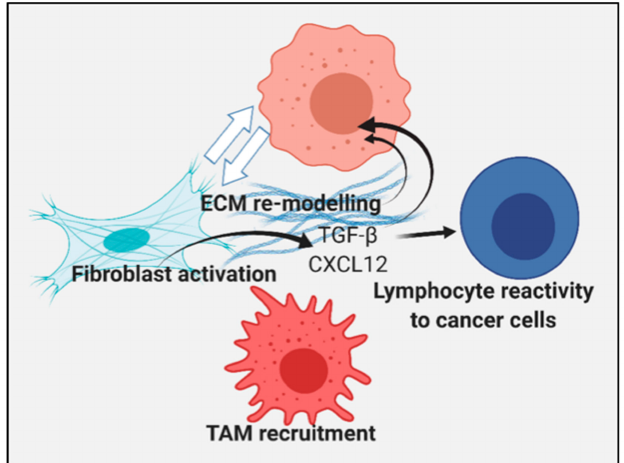
Figure 5. The activities of HSPs can promote a tumorigenic stroma. We represent cancer cells (at the top) within an extracellular stroma containing infiltrating cancer associated fibroblasts (CAFs) and tumor associated macrophages (TAMs) that a ff ect the tumor microenvironment in an HSF1 / HSP-dependent manner. The interplay between CAF and carcinoma cells is a ff ected by the HSF1 expression in each of these cell types, and the HSF1 activity promotes the secretion of the TGF- β and CXCL12 factors, which lead to the secretion of ECM molecules, such as collagens, that can modulate tumor cell behavior by a ff ecting the structure of the tumor milieu and binding to integrins on the cancer cell surface. TGF- β and CXCL12 can also influence the properties of the cancer cells and the reactivity of tumor infiltrating lymphocytes. Hsp72 has also been shown to be important for the recruitment of TAM, which can secrete growth promoting factors in an HSP-dependent